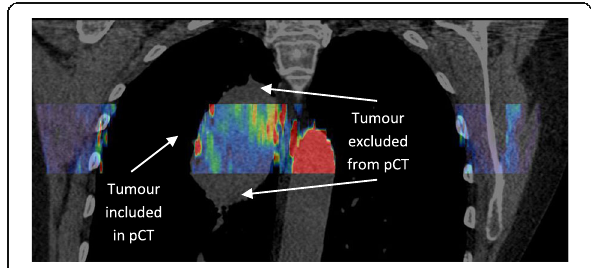
Fig. 4 A coronal slice taken from one patient; the section in color indicates the volume over which the pCT was performed, while the underlying greyscale CT is from the pre-contrast